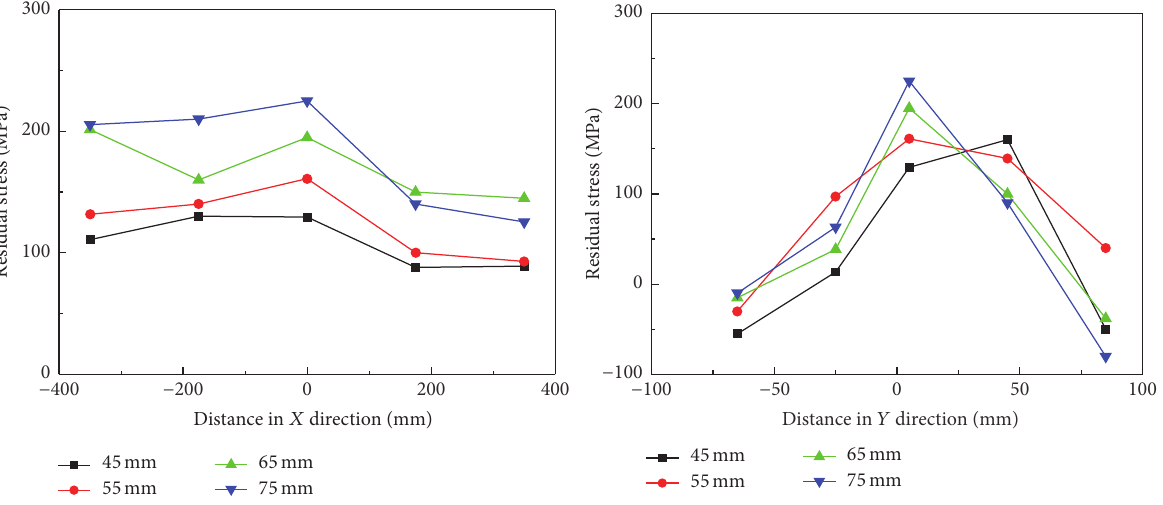
Figure 7: Transversal residual stress.